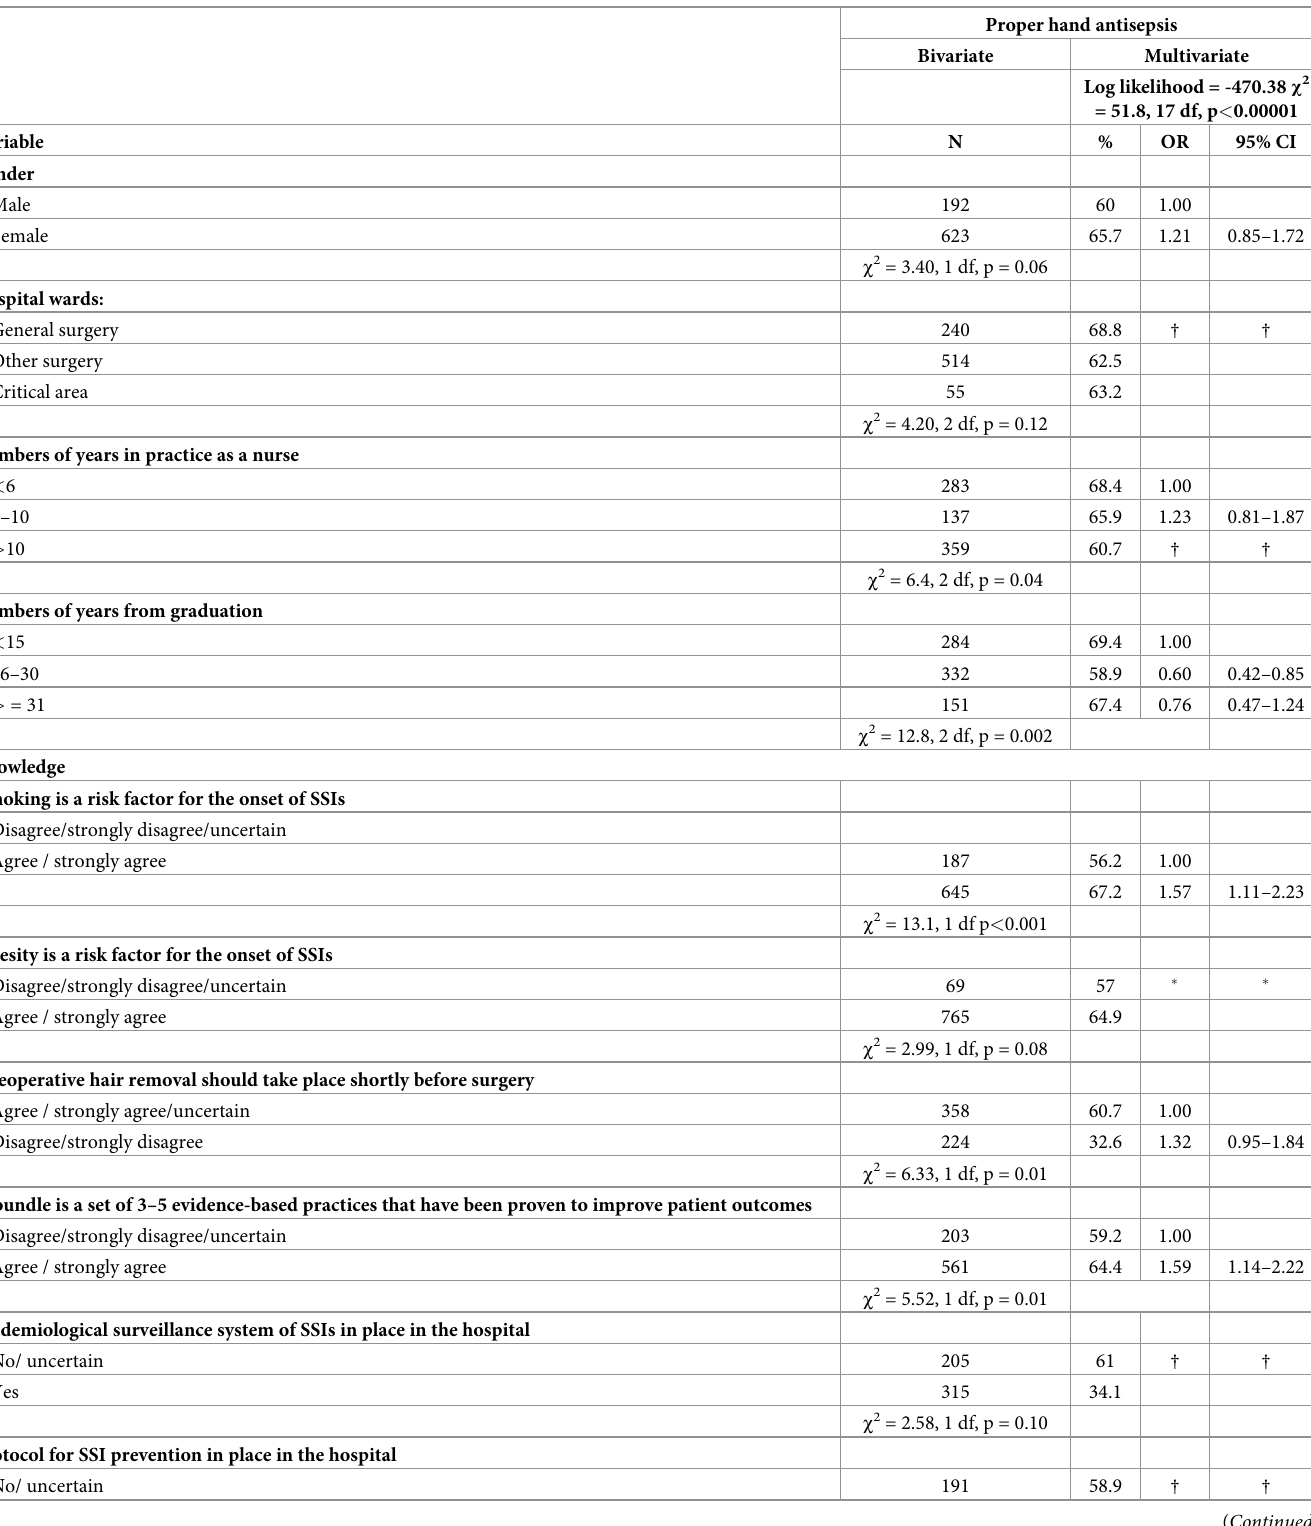
Table 3. Results of the bivariate and multivariate